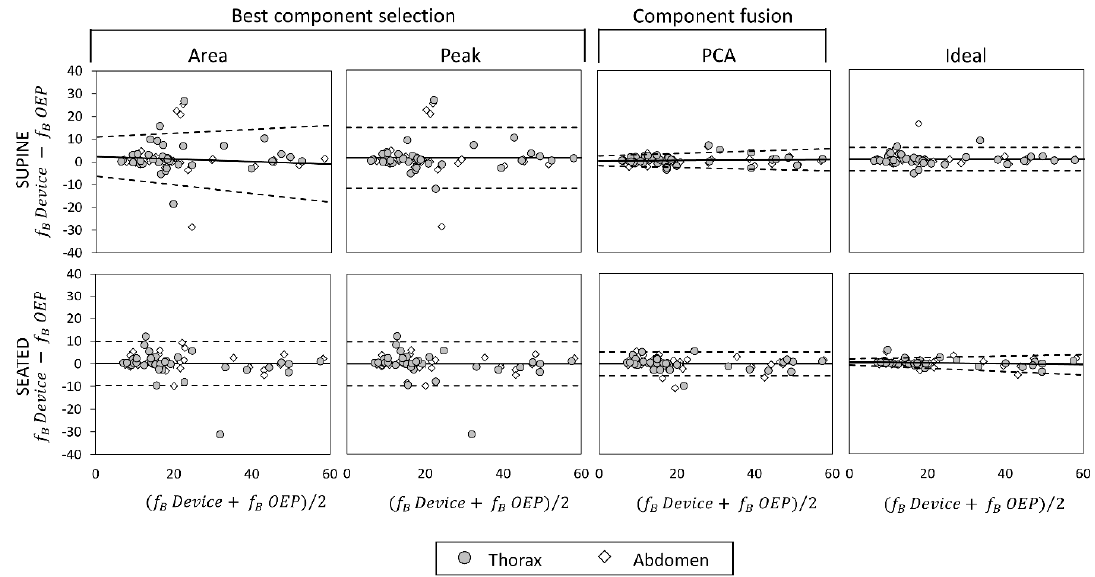
Figure 8. Agreement analysis between OEP and the IMU-based device for breathing frequency (f B , expressed as breaths/minuteute) measurements, in supine (top panels) and seated (bottom panels) position. In each Bland–Altman plot the differences between measurements of f B obtained by using the IMU-based device and by using OEP are plotted against the mean of the two measurements. For homoscedastic data, the mean of the differences (bias: —) and limits of agreement (black dotted line) from mean − 1.96 s to mean + 1.96 s are represented by lines parallel to the X axis. For heteroscedastic data, the proportional bias (—) is represented by the ordinary least squares (OLS) line of best fit for the difference on mean values; V-shaped upper and lower 95% confidence limits (- - -) are calculated according to Bland [44].